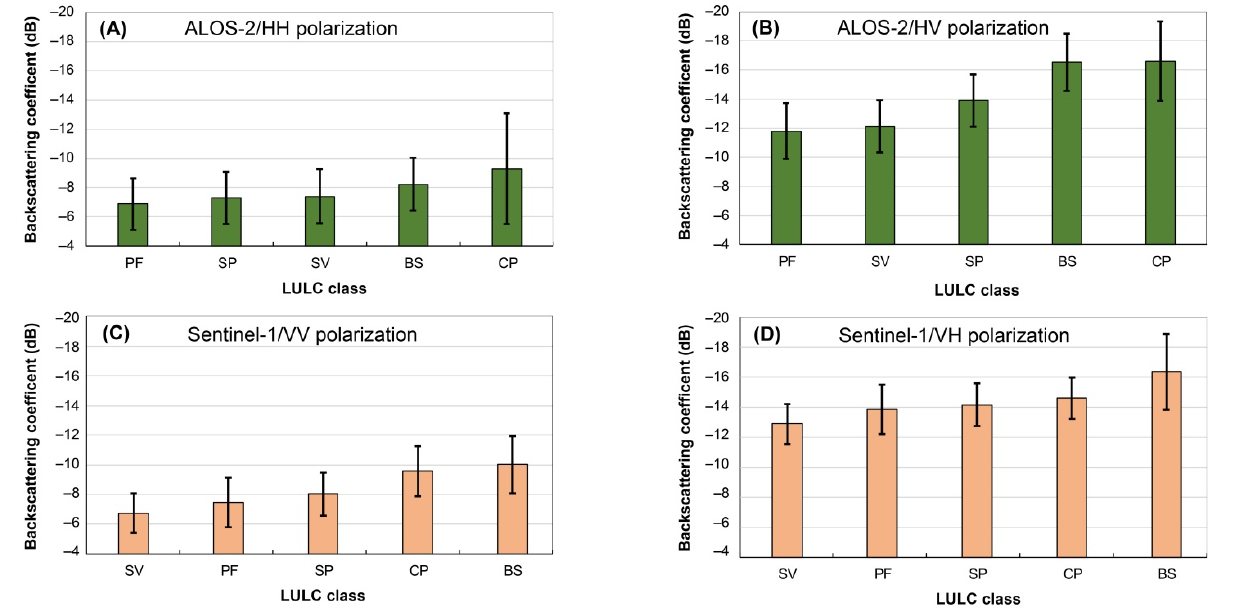
Figure 4. Backscattering coefficients of primary forest (PF), shrubby pasture (SP), secondary vege- tation (SV), bare soil (BS), and clean pasture (CP), derived from L-HH ( A ), L-HV ( B ), C-VV ( C ), AND C-VH ( D ) polarizations.